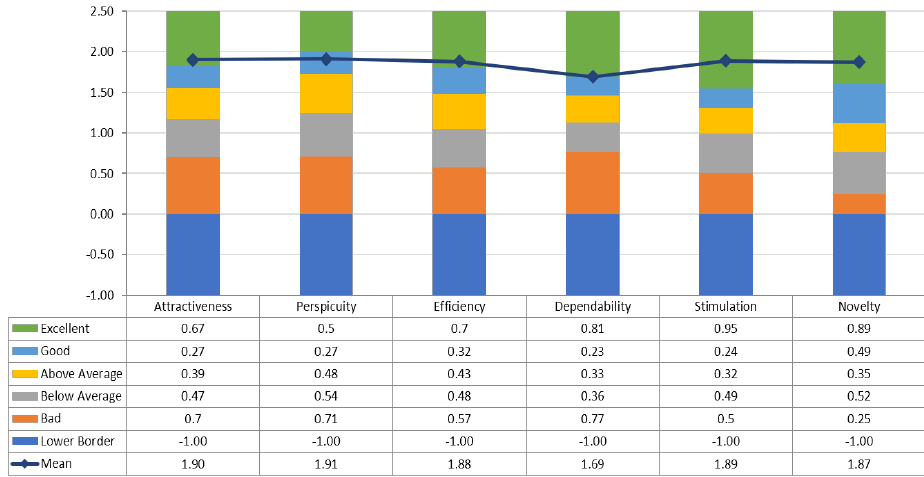
Figure 11. MIRA user experience questionnaire scores on six dimensions scales along with benchmark